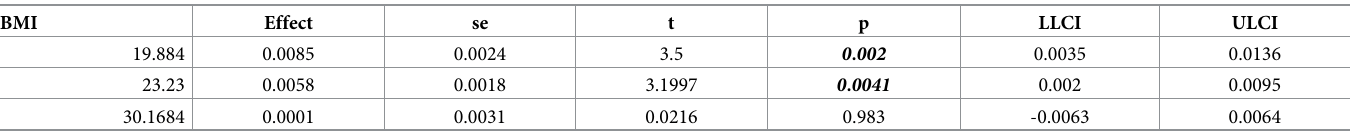
Table 3. Conditional effects monthly CB use at values of the moderator(s).